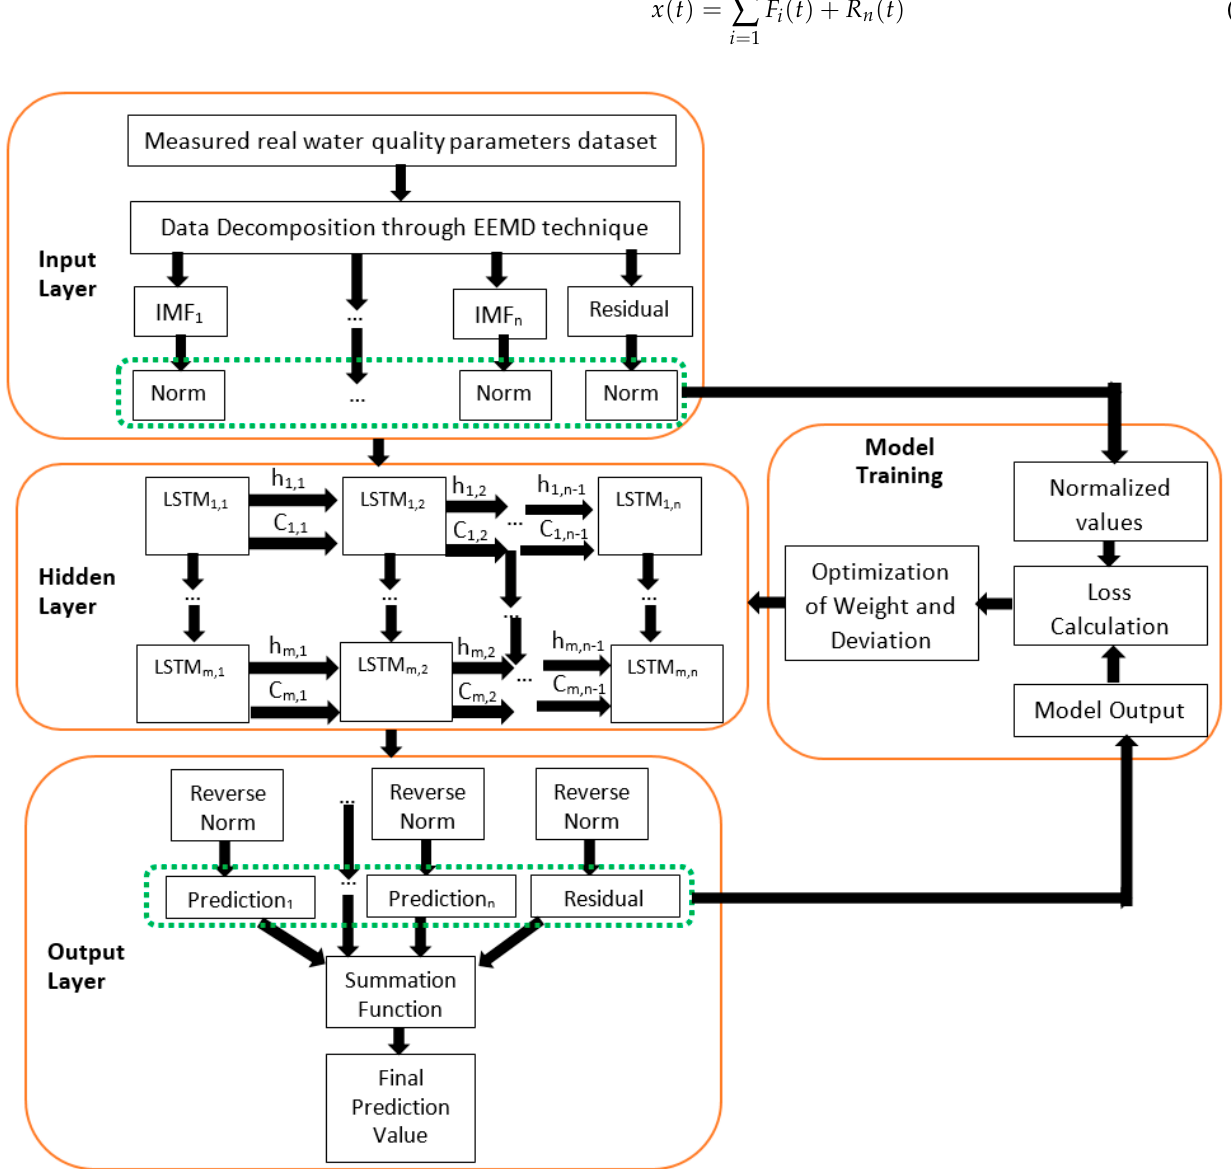
Figure 5. The proposed hybrid EEMD-DL-LSTM NN-based water quality parameters prediction model.